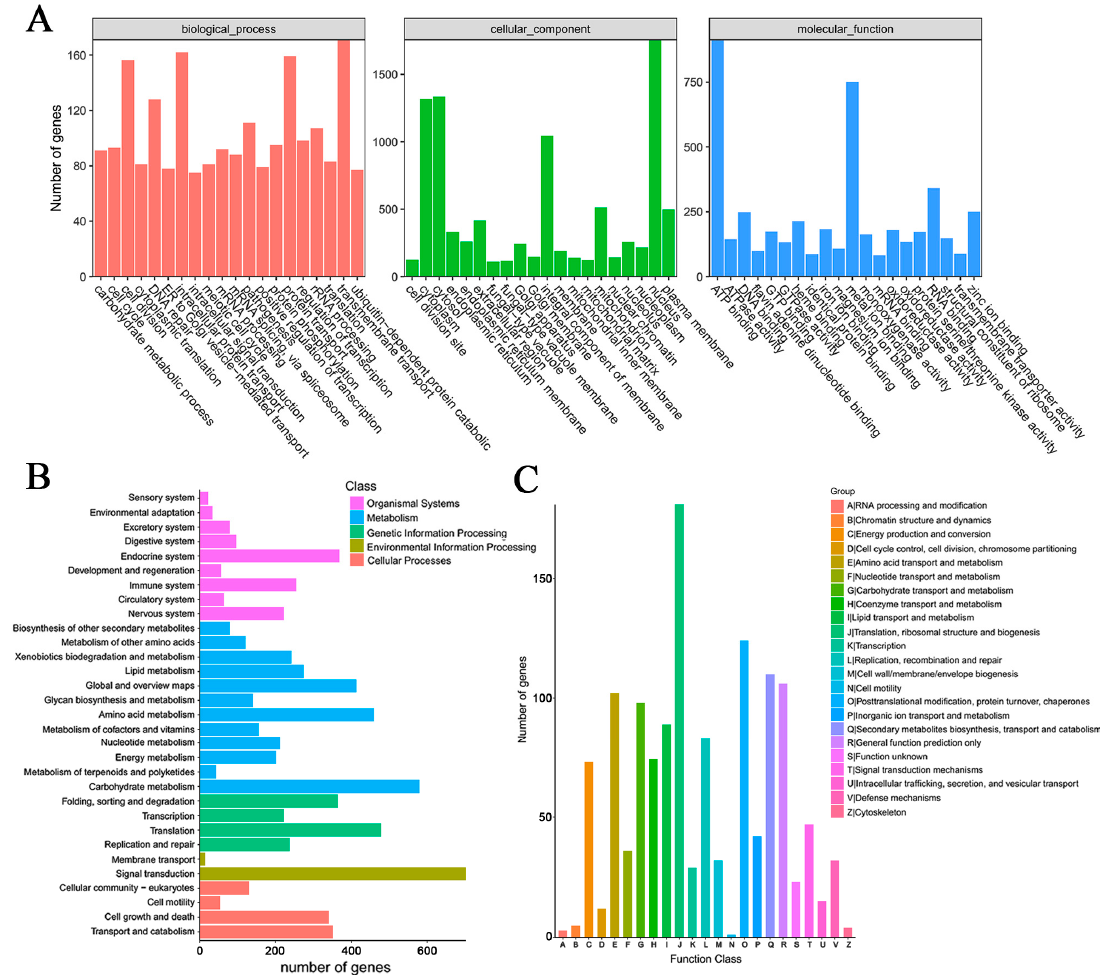
Figure 1. Function annotation of predicted genes in G. lingzhi. ( A ) The GO function annotation of predicted genes in G. lingzhi . Biological processes, cell components, and molecule functions are three categories of functional analysis. Counts for each category represent the total associated terms in the database with the query gene list. Terms with a p -value < 0.05 are statistically significant. The 20 most significantly enriched terms were listed, and the number of involved genes in a term is shown on the left y-axis. ( B ) KEGG analysis of predicted genes in G. lingzhi . Enriched KEGG pathways are